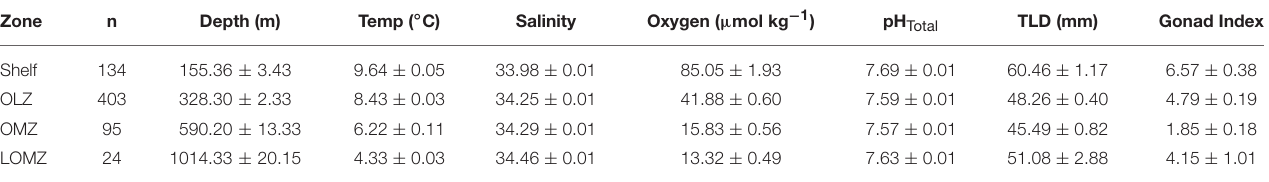
TABLE 1 | Mean values ( ± 1 SE) of hydrographic variables (Depth, Temperature, Salinity, Oxygen, and in situ pH Total ), gonad index (% weight) and total length of the test diameter of urchins separated by depth zone bin.